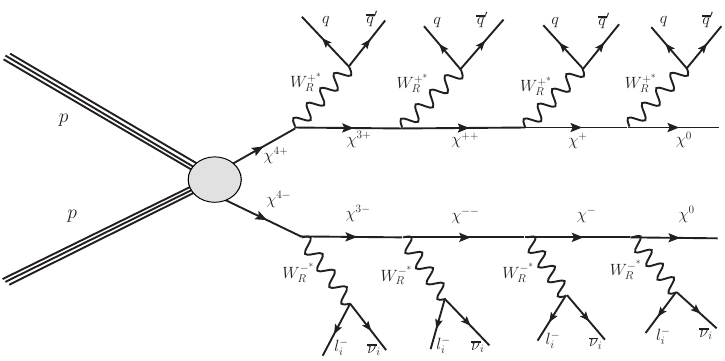
Figure 5 . Cascade decay of (cid:31) 4 (cid:6) into leptons ( l = e; (cid:22) ) and jets, contributing to the 4SSL channel.